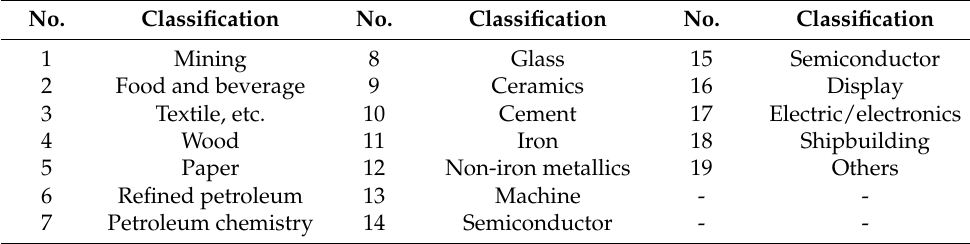
Table 2. Classification by industry